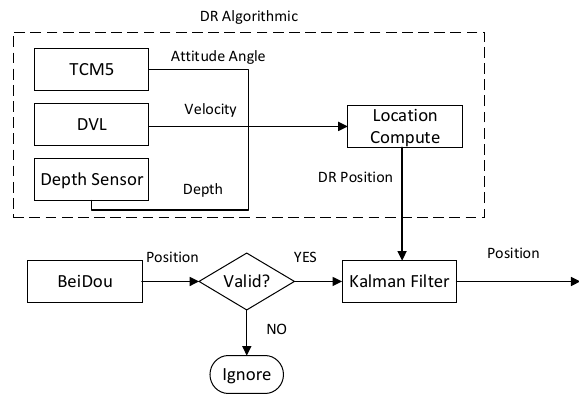
Figure 9. Logic diagram of navigation algorithm.